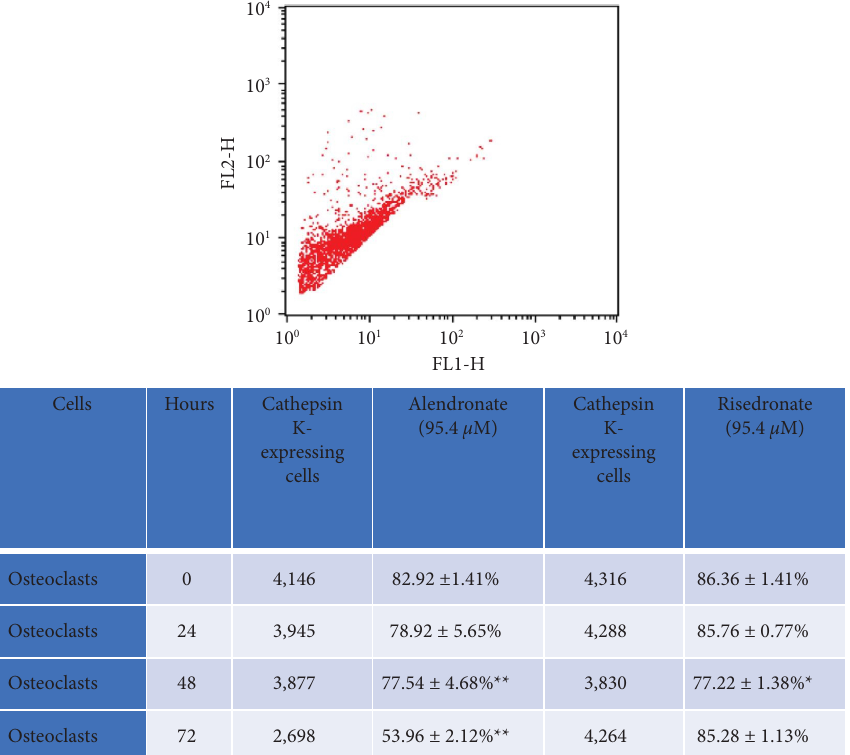
Figure 4: Comparison of cathepsin K expression in cultured osteoclasts stimulated in vitro with alendronate (95.4 mM) or risedronate (95.4 mM) with that in control cells. Signifcant downregulation of cathepsin K at 48 and 72h with alendronate ∗∗ and at 48h with risedronate; ∗ P < 0 . 05 and ∗∗ P < 0 . 001. Te plot shows fow cytometry staining